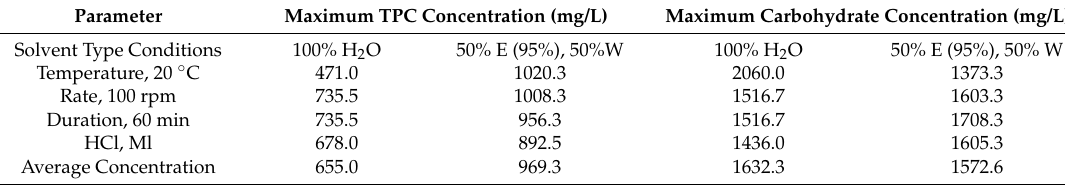
Table 1. TPC and carbohydrates concentration values (mg/L) in the extracted